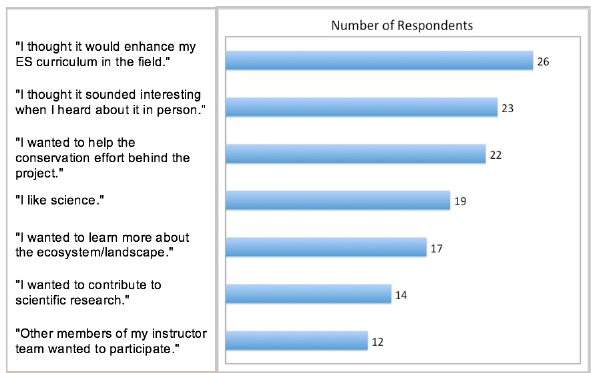
Figure 3: Frequency of statement selections in response to the online questionnaire item: “Which of the follow- ing influenced your decision to participate in the pro- ject?” Respondents could choose multiple statements and did not rank their top motivation among multiple